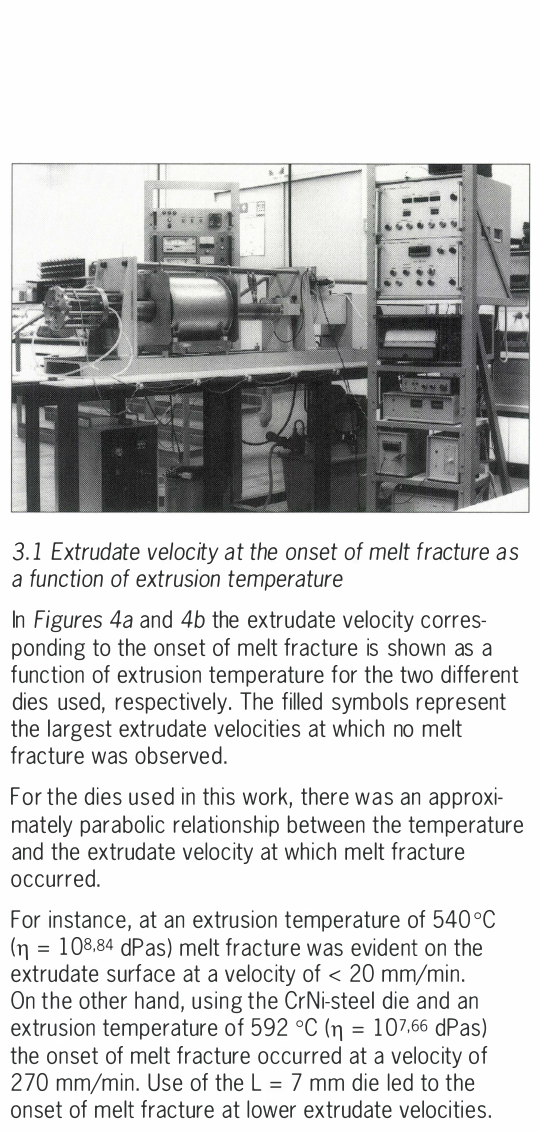
Complete view of the extrusion device